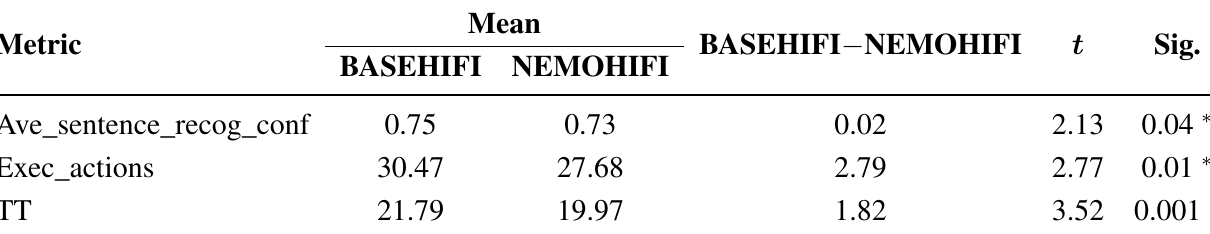
Table 4. The objective metrics with significant differences between BASEHIFI and